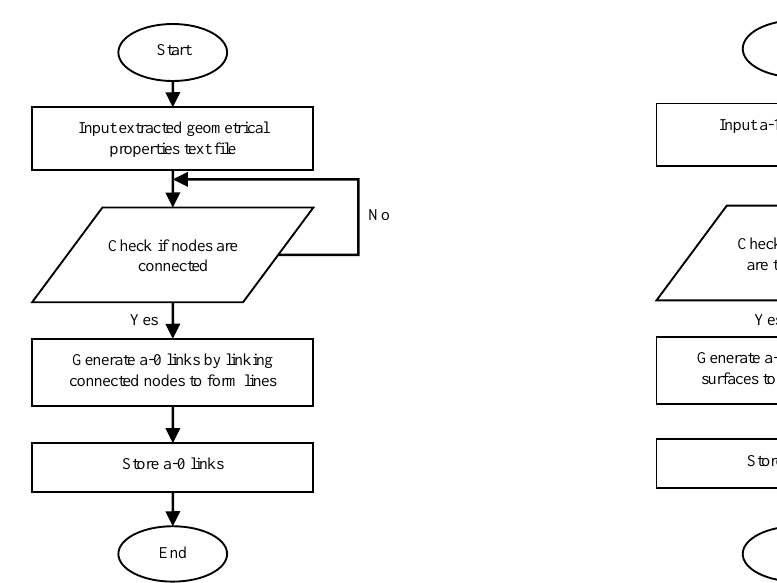
Figure 6. Flowchart for generating a-0 links